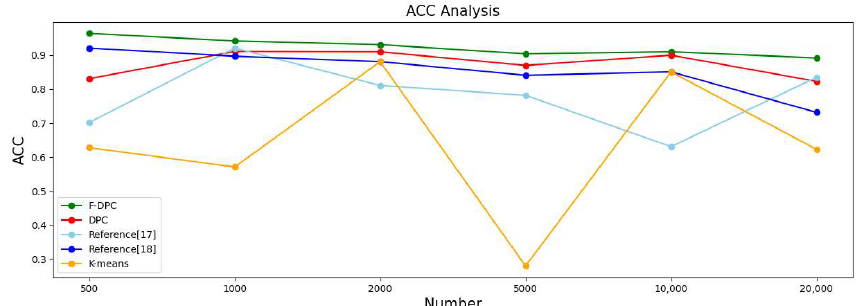
Figure 14. Line chart of evaluation index ACC [17,18].